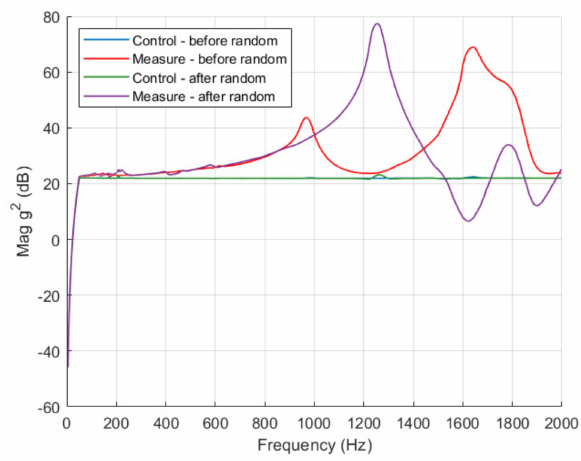
Figure 8. Resonances before and after tests on y axis, AA 6081 spindle.